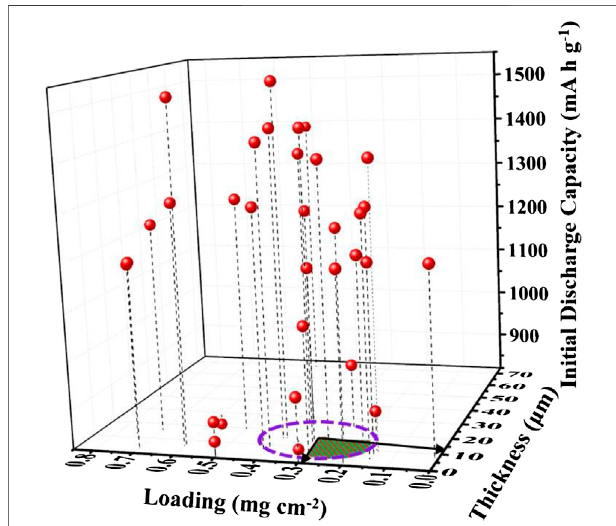
FIGURE 9 | The relationship between the loading and thickness of functional separators and the corresponding initial discharge capacities of LSBs.